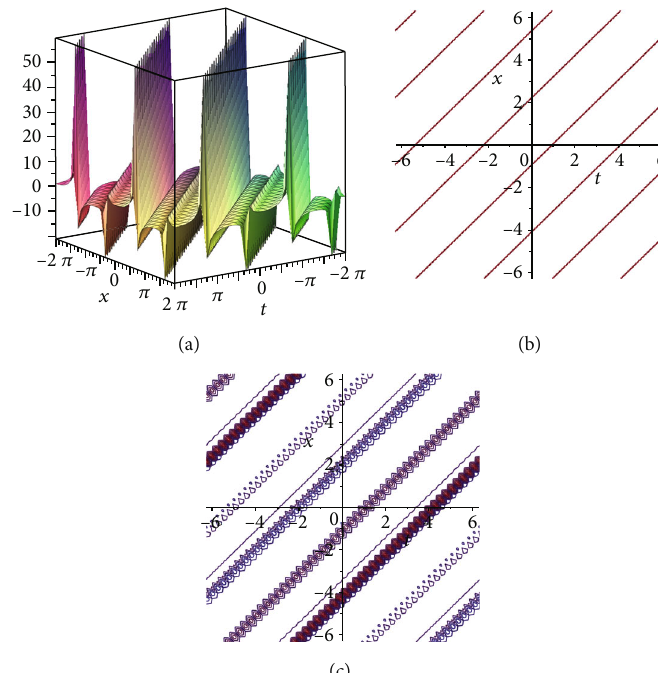
ð ξ Þ . Figure 3: The 3D, 2D, and contour images of Φ 317 Figure 4: The 3D, 2D, and contour images of Φ 318 ð ξ Þ , we Figure 3: The 3D, 2D, and contour images of Φ 317 ð ξ Þ , we take the values of β 1 = 1 , β 2 = 4 , β 3 = 3 , β 4 = 2 , y = 1 , and take the values of β 1 = 1 , β 2 = 4 , β 3 = 3 , β 4 = 2 , y = 1 , and q = 1 ; the graphs clearly demonstrate the multiperiodic q = 1 ; the graphs show the periodic curved parabolic struc- characteristic of Φ 317 ð ξ Þ on the domain. ture of Φ 318 ð ξ Þ on the domain.